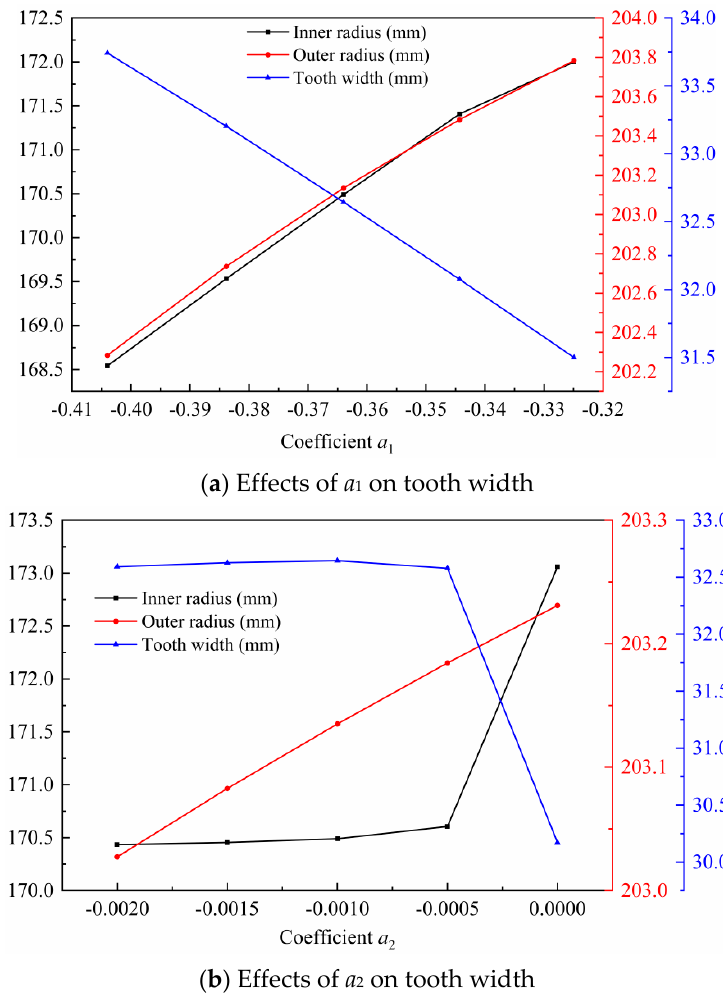
Figure 5. Effects of a 1 and a 2 on tooth width characteristics.